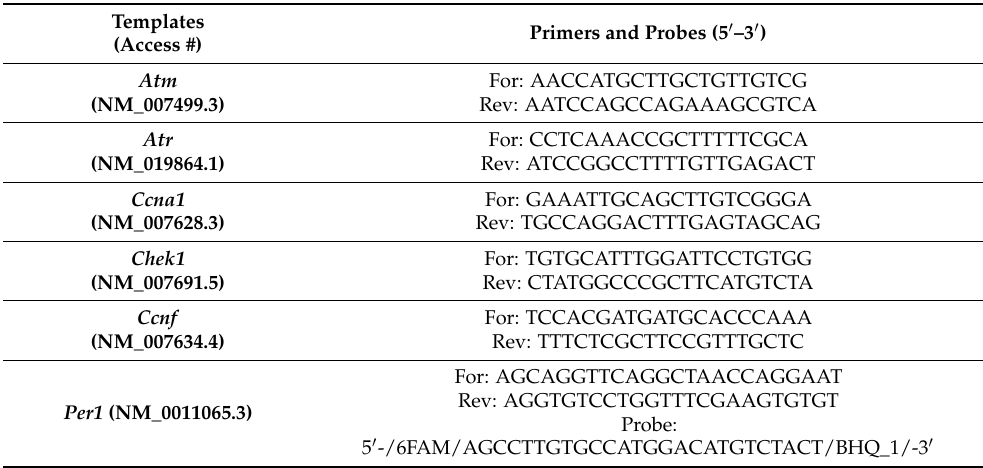
Table 1. Primers, sequences, and access